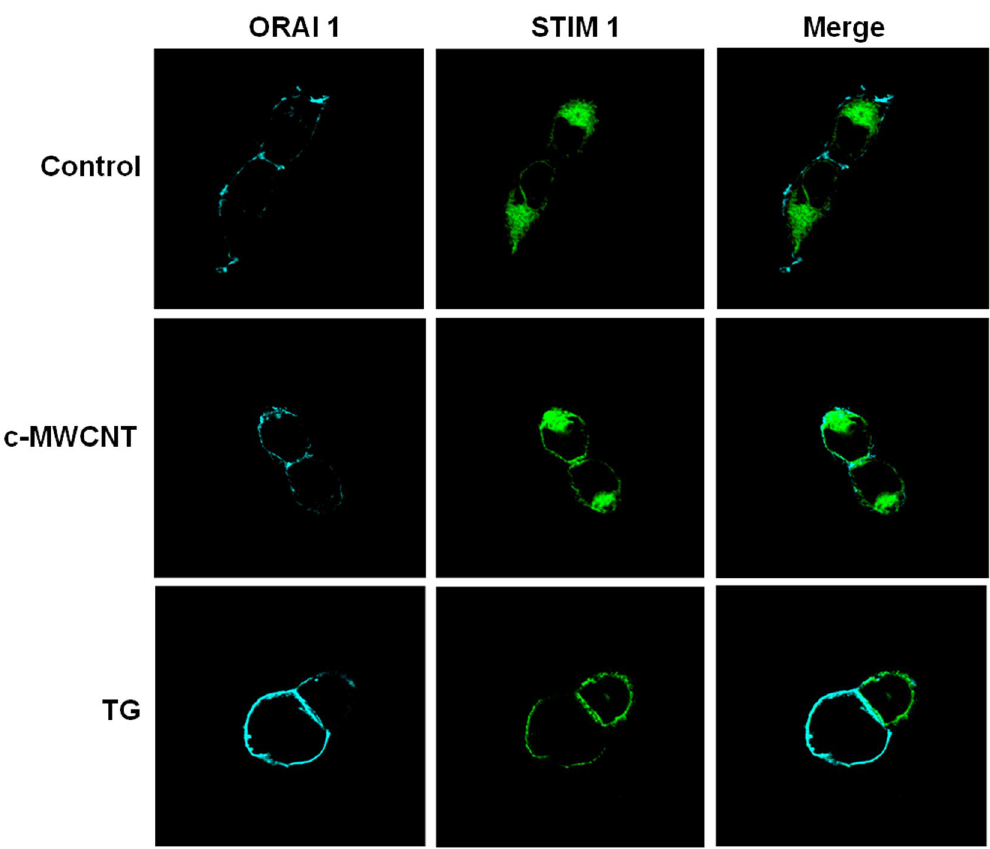
Figure 4. Confocal microscopy showing the cellular localization of Orai1 and STIM1 in the transfected HEK293 cells before and after treatment with c-MWCNTs (50 μ g/ml, 24 h) and TG (1 μ mol/L, 30 min). Note that Orai1 is uniquely located in the plasma membrane (PM). STIM1 distributed mainly in the cytoplasm and slightly in the PM at baseline (control), while it significantly translocated to the PM after treatment with c-MWCNTs or